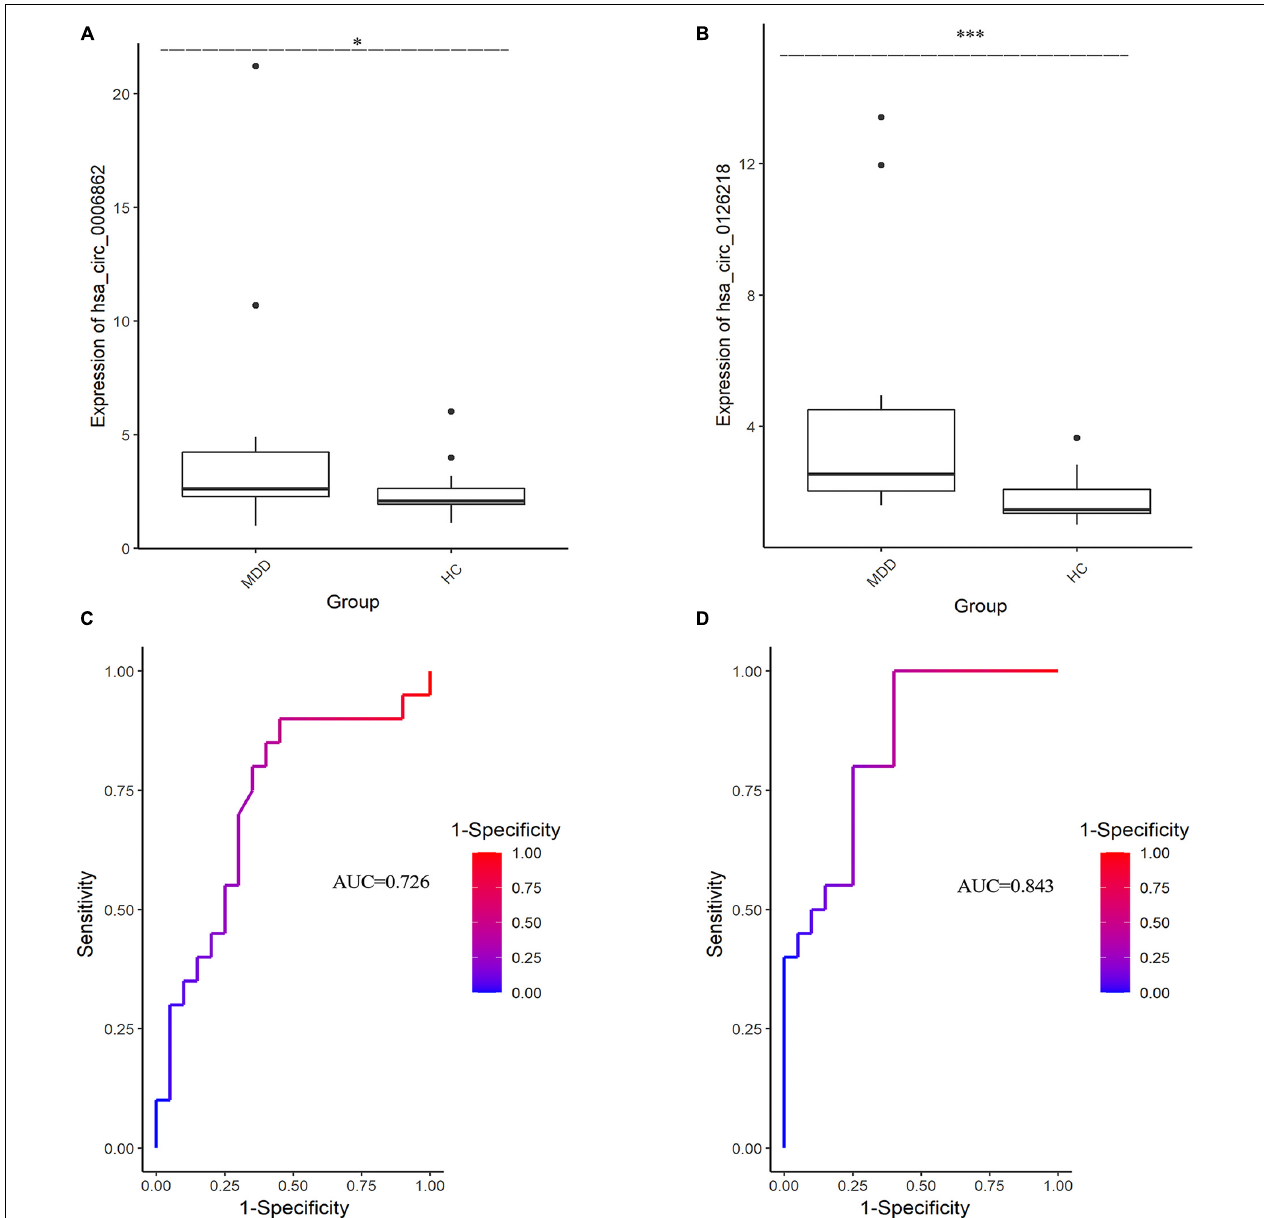
FIGURE 1 | The differential expression levels and ROC curves of circRNAs in PBMCs between MDD patients (MDD, n = 20) and healthy controls (HC, n = 20) by qRT-PCR. Mann-Whitney test was utilized for data analysis. (A) The expression of hsa_circ_0006862 in MDD is significantly higher than that in HC. (B) The expression of hsa_circ_0126218 in MDD is significantly higher than that in HC. (C) ROC curve analysis of hsa_circ_0006862. (D) ROC curve analysis of hsa_circ_0126218. ROC, receiver operating characteristic.